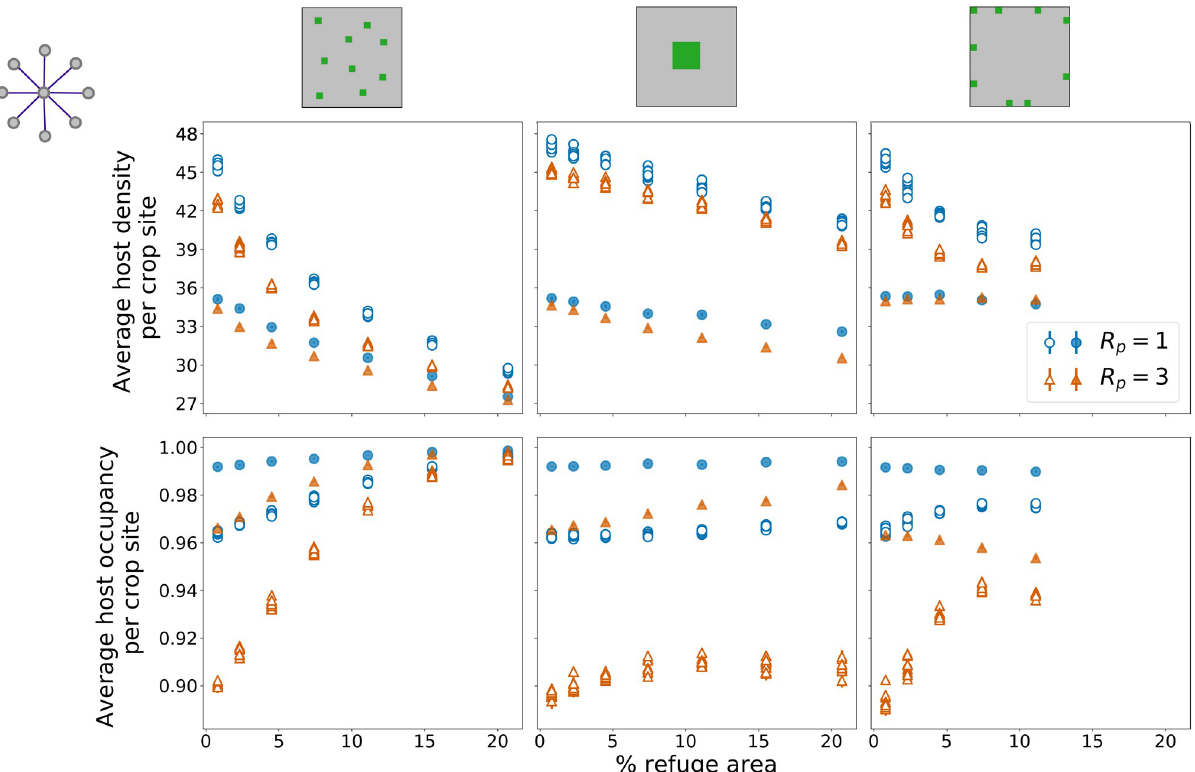
Fig 3. Host variables—Star network. Average host density per crop site (first row) and average host occupancy per crop site (second row) as functions of the percentage of refuge areas on the lattice, for random, block, and border distributions of refuge areas (first, second, and third columns, respectively). Ten points are shown for each percentage of refuge areas, one for each node on the external network. Peripheral nodes are represented as empty symbols and central nodes as filled symbols. Each point corresponds to the average density or occupancy for that node over 50 simulations, with error bars showing one standard error of the mean. Results are shown for two values of parasitoid dispersal radius R (orange triangles). External network (regional connectivity) has star